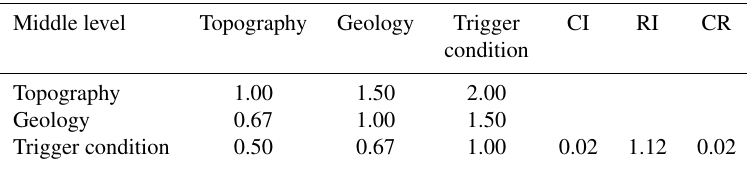
Table 11. Comparison matrix elements of the criterion level factors. Middle level Topography Geology Trigger